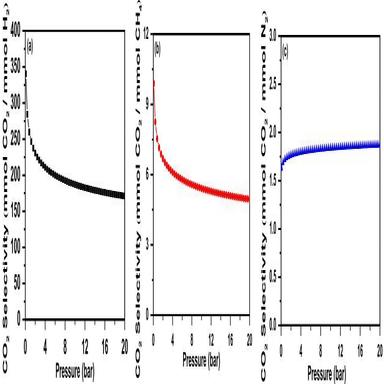
IAST selectivities for EC-RF of (a) 40/60 CO2/H2, (b) 50/50 CO2/CH4, (b) 10/90 CO2/N2 mixtures from 0 to 20 bar at 25 ◦C.